Question: What style of plot is this figure drawn as?
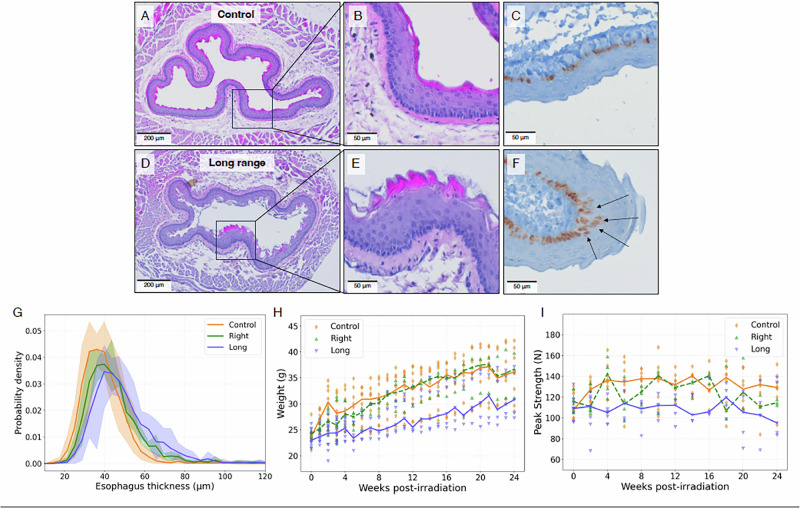
Answer: histogram